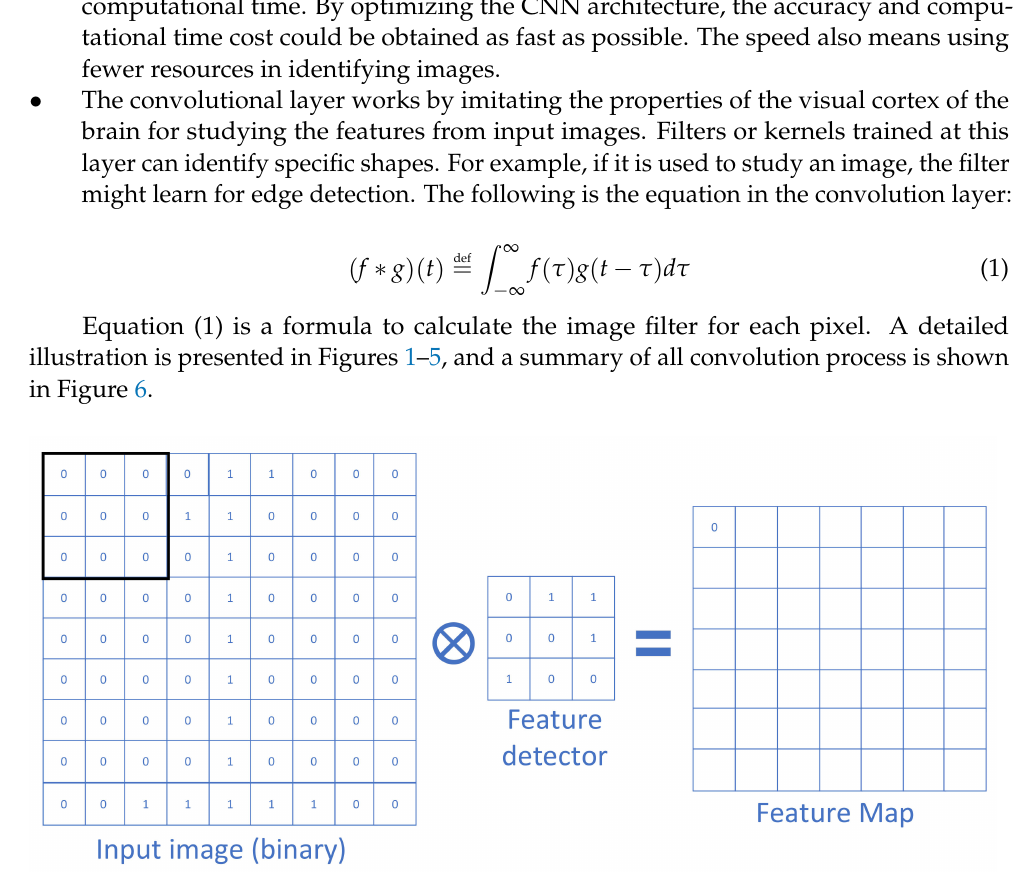
Figure 1. Binary conversion of feature map